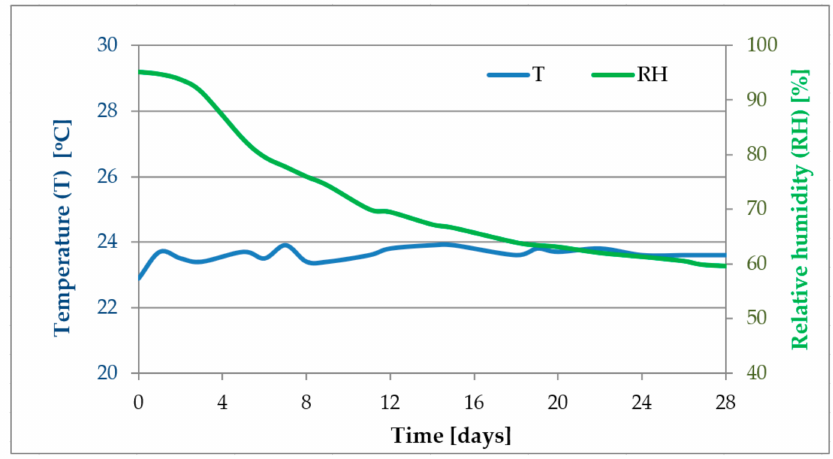
Figure 4. Temperature and relevant humidity during the test for ammonia emissions.